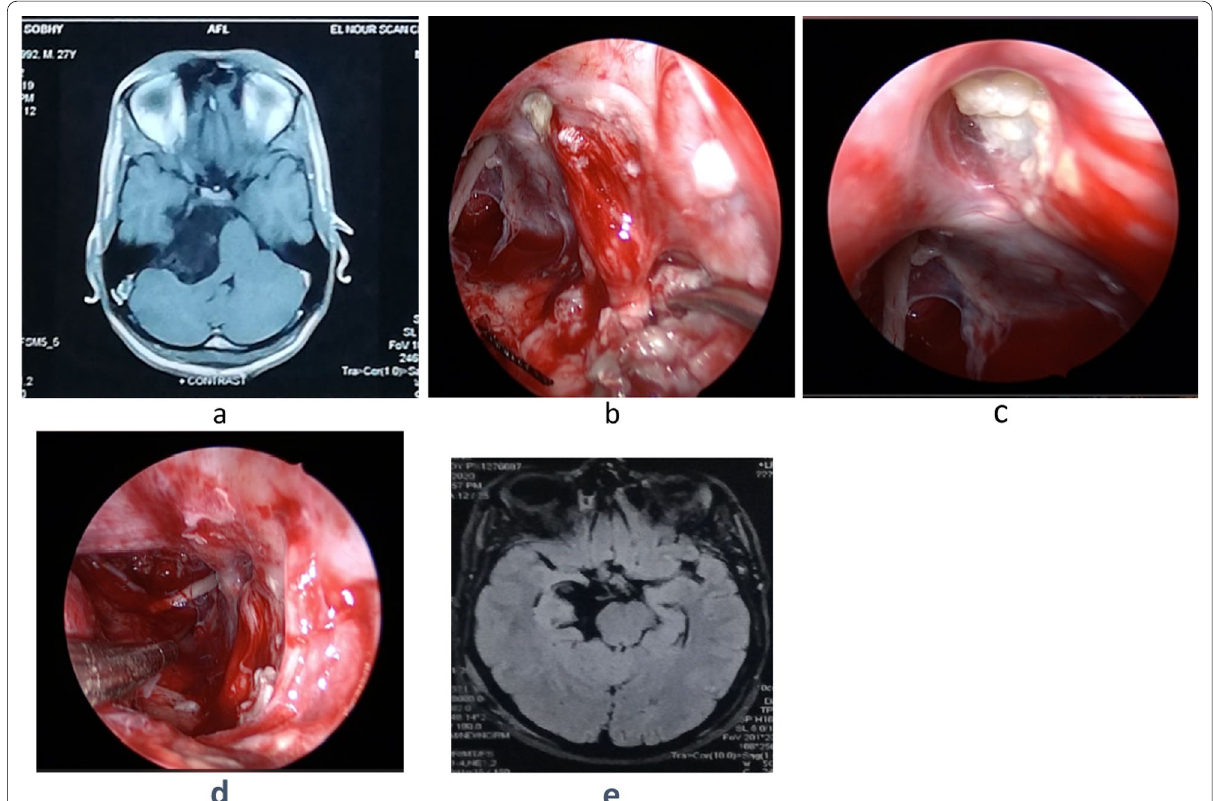
Table 2 Presence of post-operative new facial palsy based